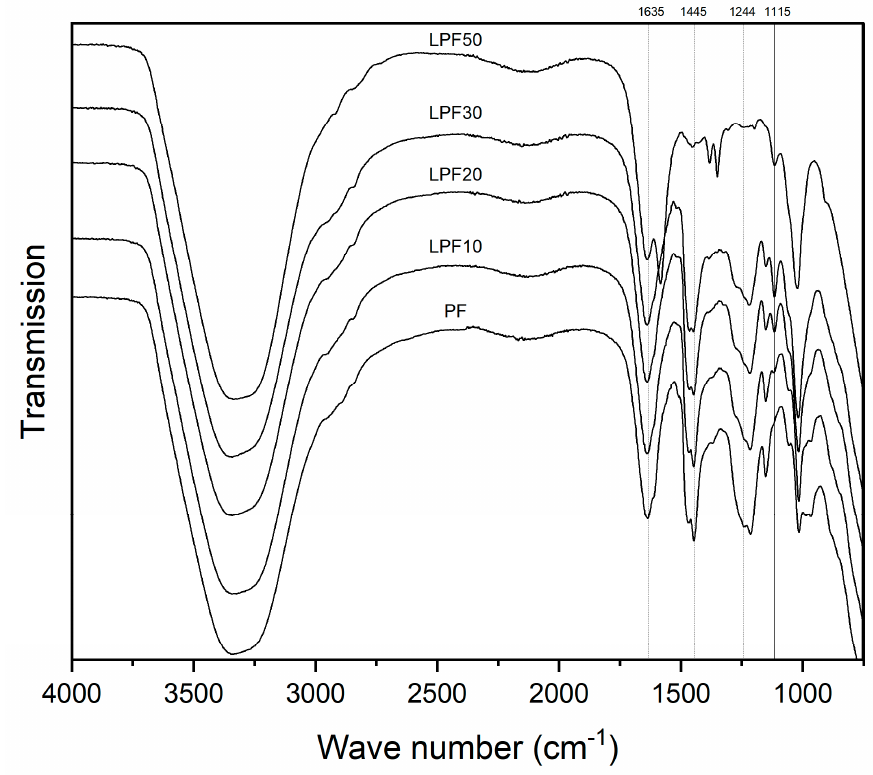
Figure 7. FTIR analysis of different resins.